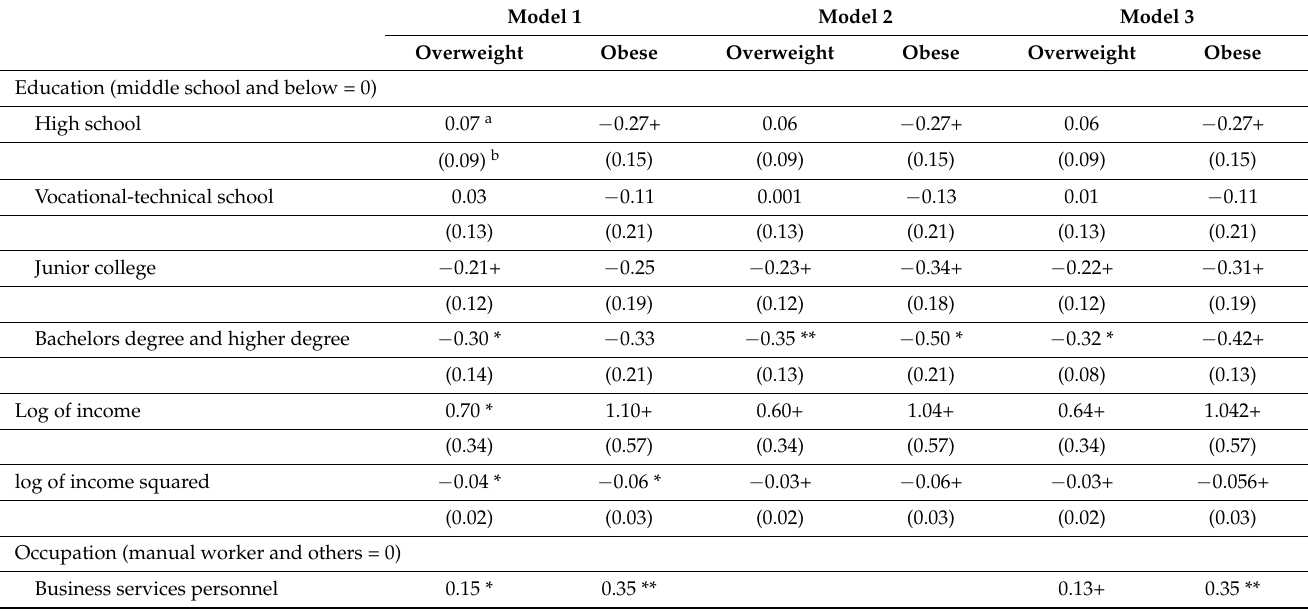
Table 6. Logistic regression analyses for being overweight and obese ( n =